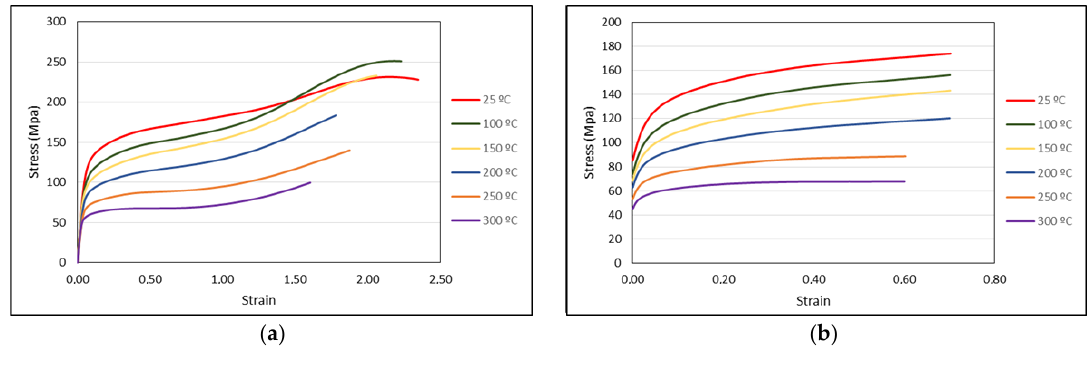
Figure 3. ( a ) Universal testing machine; ( b ) design of the plane ‐ shape dies; and ( c ) resistance system for performing the compression tests at